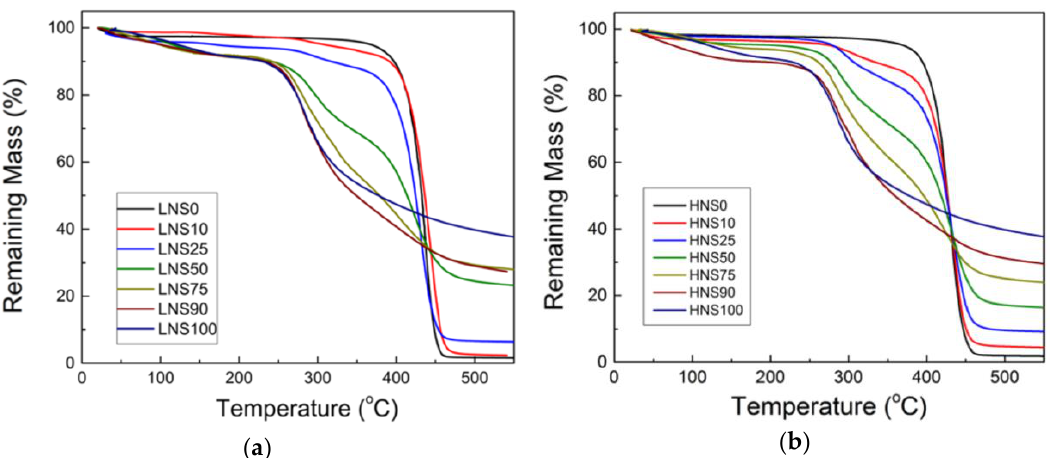
Figure 4. Thermogravimetric analysis demonstrates mass loss of ( a ) silk-nylon 610 (LNS) and ( b ) silk-nylon 1010 (HNS) blend films.